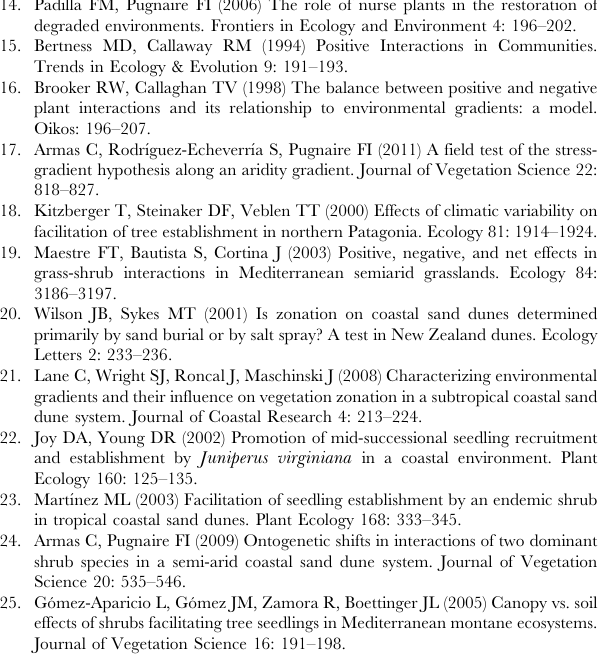
Figure S3 Daily mortality rate of Ternstroemia brasi- liensis seedlings per time interval along all the exper- iment. Figure S4 Proportion of surviving seedlings of Tern- stroemia brasiliensis at three levels of the factor proximity to the seashore (I - closest; III – farthest) and three levels of the factor neighbor. Figure S5 Random effects and their 95% interval on survival of Ternstroemia brasiliensis seedlings in the three levels of the neighbor treatment (control, under